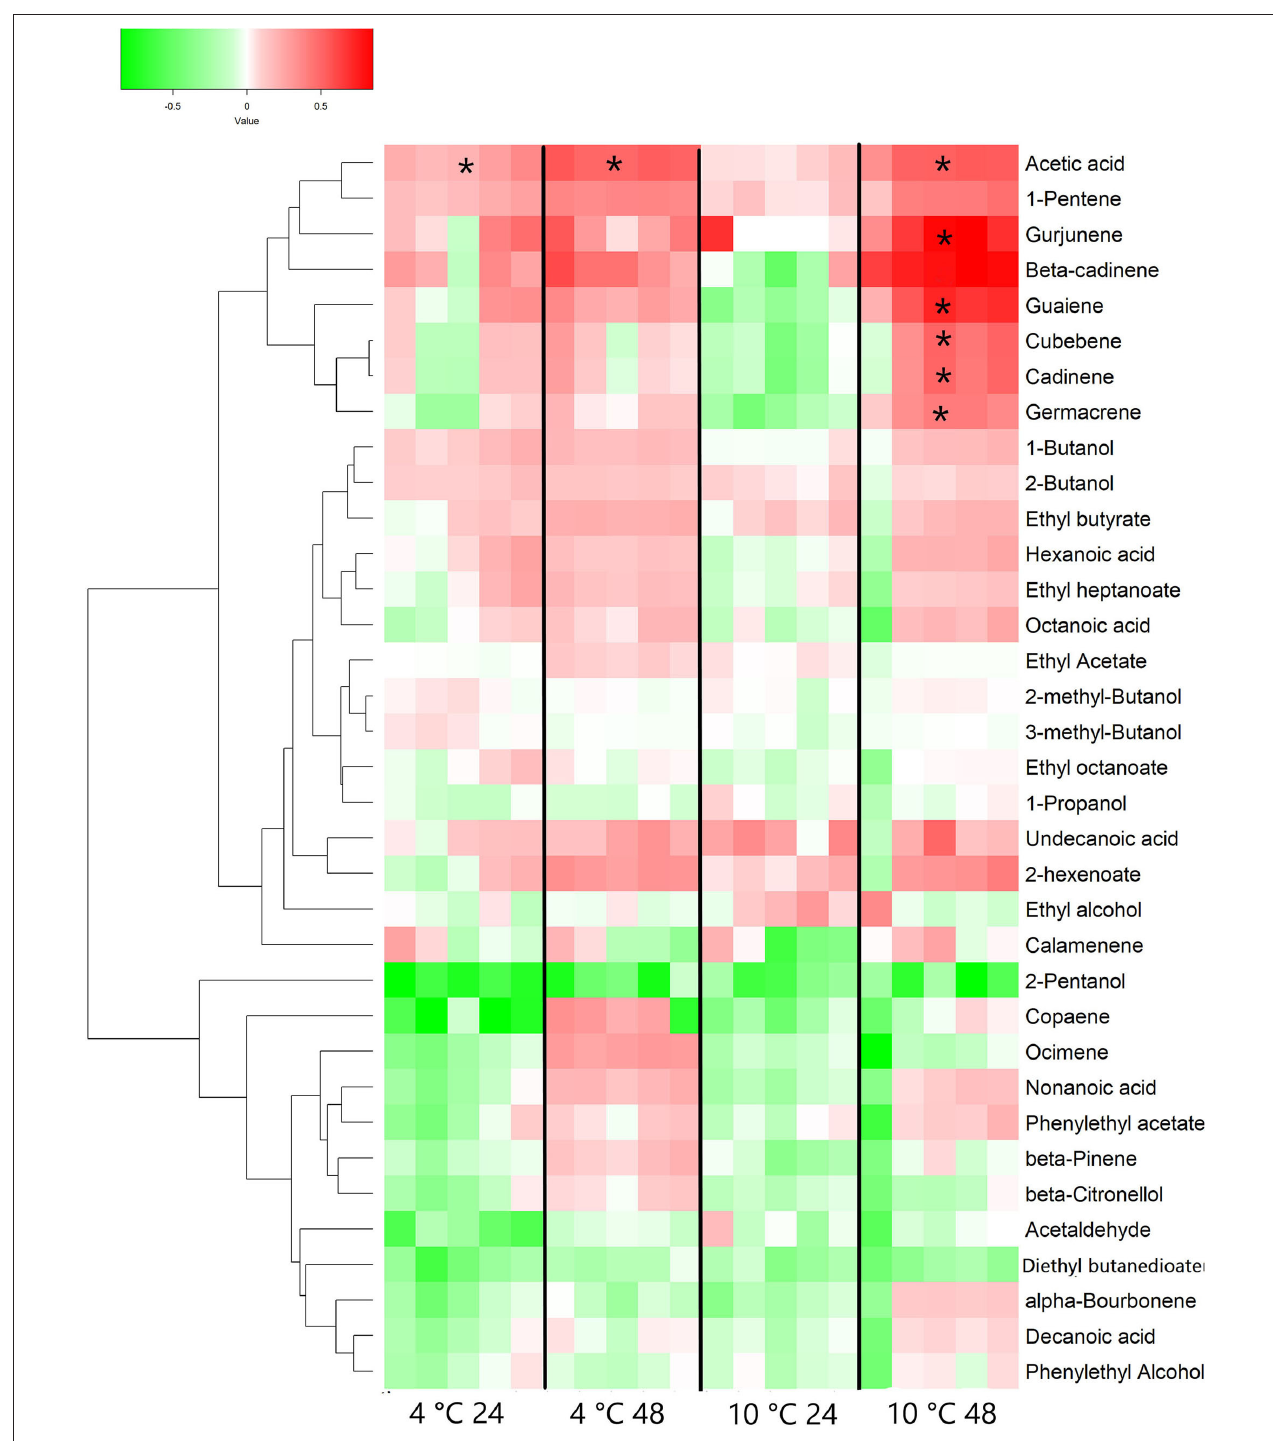
FIGURE 5 | Heatmap and Hierarchical Cluster Analysis performed on VOCs measured in wine made from Vermentino grapes following cooling treatment at 4 and 10 ◦ C for 24 and 48h. The heatmap shows the fold change of identified VOCs. Each cell represents the level of each compound in each of the five analyzed replicates for the specific postharvest condition, normalized to its level at harvest (T0) and transformed in logarithmic scale as following: log 2 (FC) = log 2 [replicate/mean(T0)]. A Pearson correlation coefficient was employed in order to group the different features, using average as clustering algorithm. * Represents statistically significant difference based on ANOVA and Tukey post-hoc test with p ≤ 0.05 performed between treatments and T0 grapes.